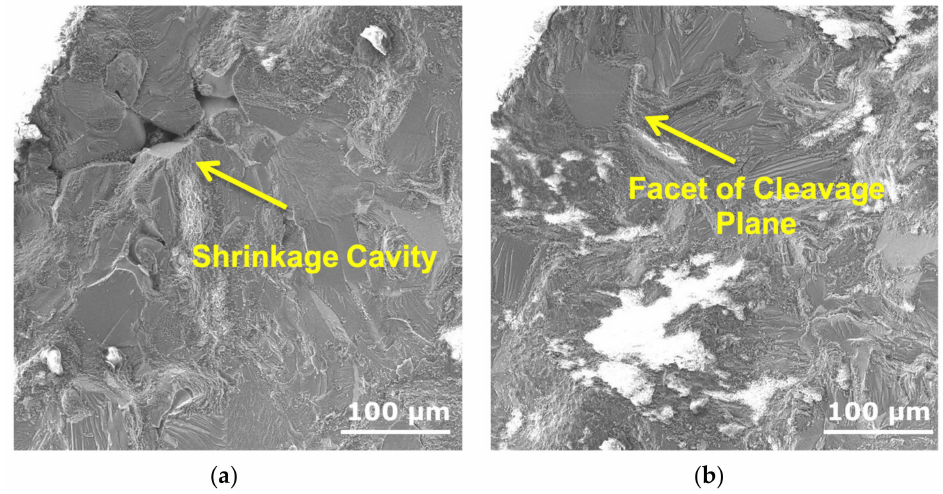
Figure 13. Fatigue tests (4-point rotating bending), fracture surface analysis: SEM images showing crack initiation below the ECO layer-substrate interface at a shrinkage cavity ( a ) and isolated facet of cleavage plane ( b ) in ECO-treated EV31A-T6